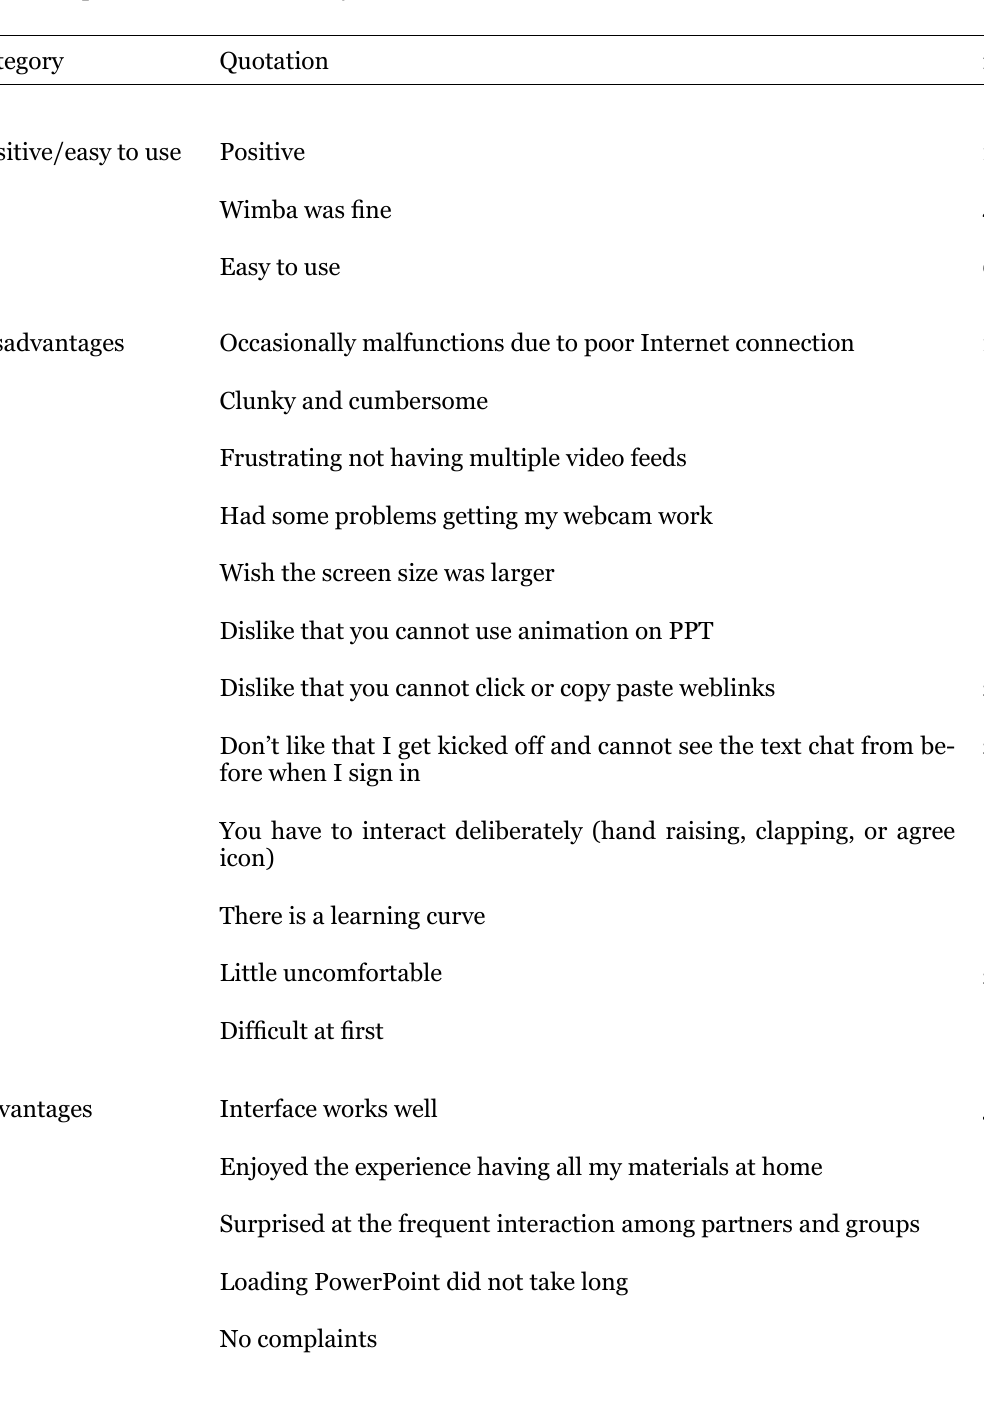
Student Responses to Learner-Interface